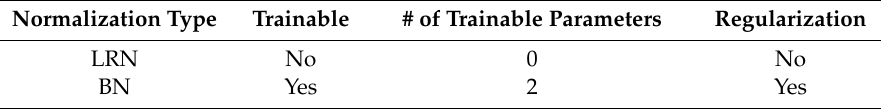
Table 1. Di ff erence between local response normalization and batch